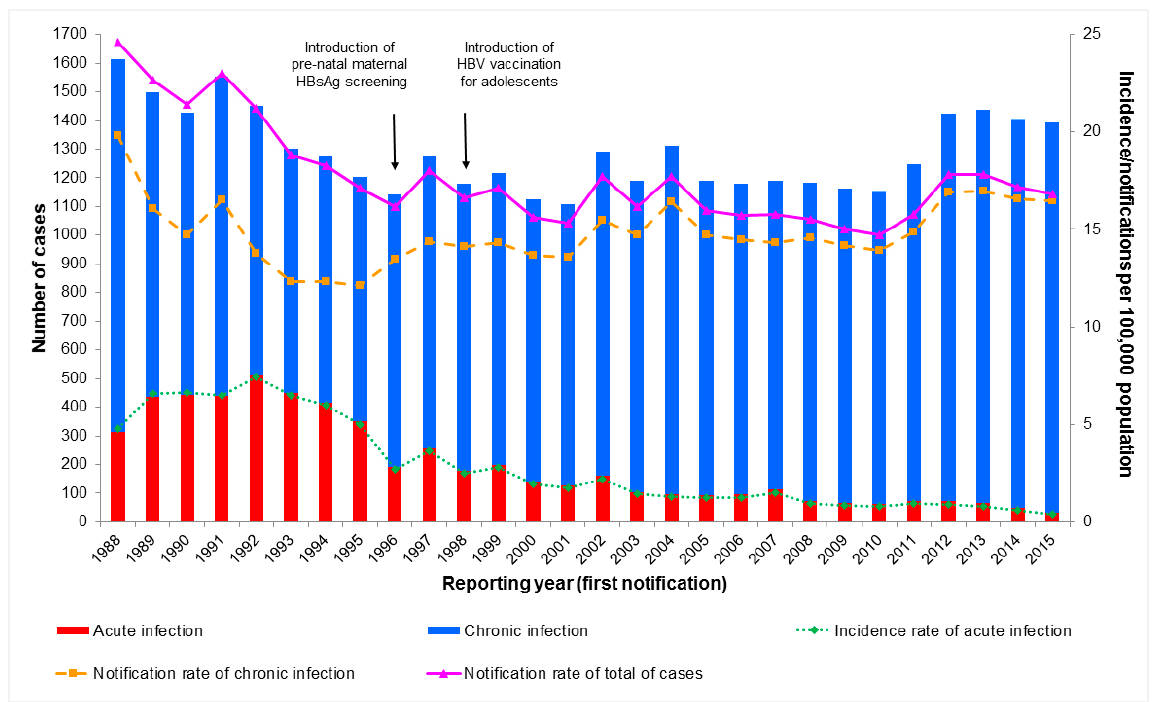
Figure 1: Notified acute and chronic hepatitis B virus infection with annual incidence and notification rates, Switzerland, 1988–2015. HBsAg = hepatitis B virus surface antigen; HBV = hepatitis B virus.